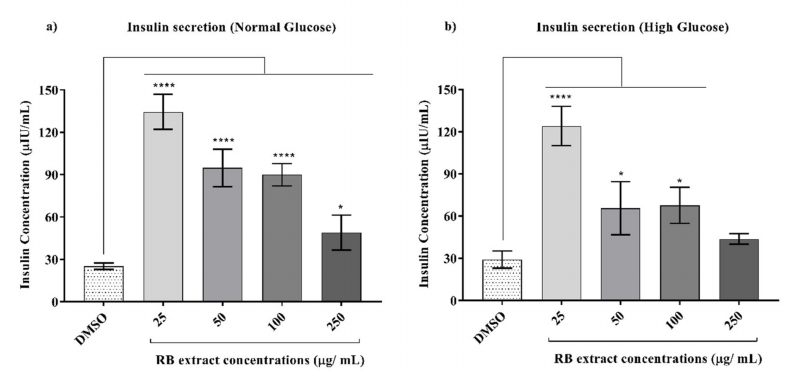
Figure 7. E ff ect of RB phenolic extracts on glucose-stimulated insulin secretion under normal and high glucose conditions in INS-1E cells. ( a ) Normal glucose conditions, ( b ) High glucose conditions ( n = 6). The level of significance is indicated by the asterisks, whereby * p < 0.05, **** p < 0.0001. Data are presented as Mean ± SD. Dimethyl sulfoxide, DMSO; Insulin-secreting rat insulinoma cell, INS-1E; Rice bran,